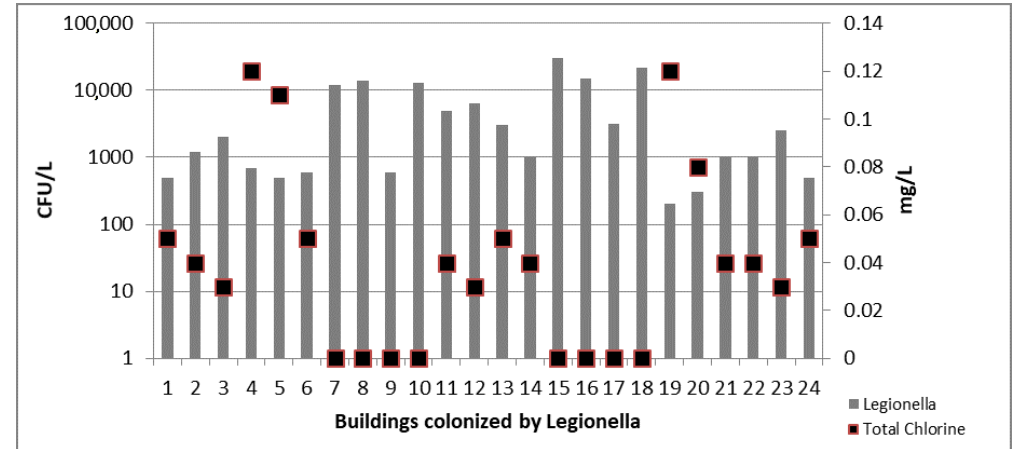
Figure 2. Legionella counts and total chlorine concentration detected in 24 colonized CB. Int. J. Environ. Res. Public Health 2017 , 14 , x